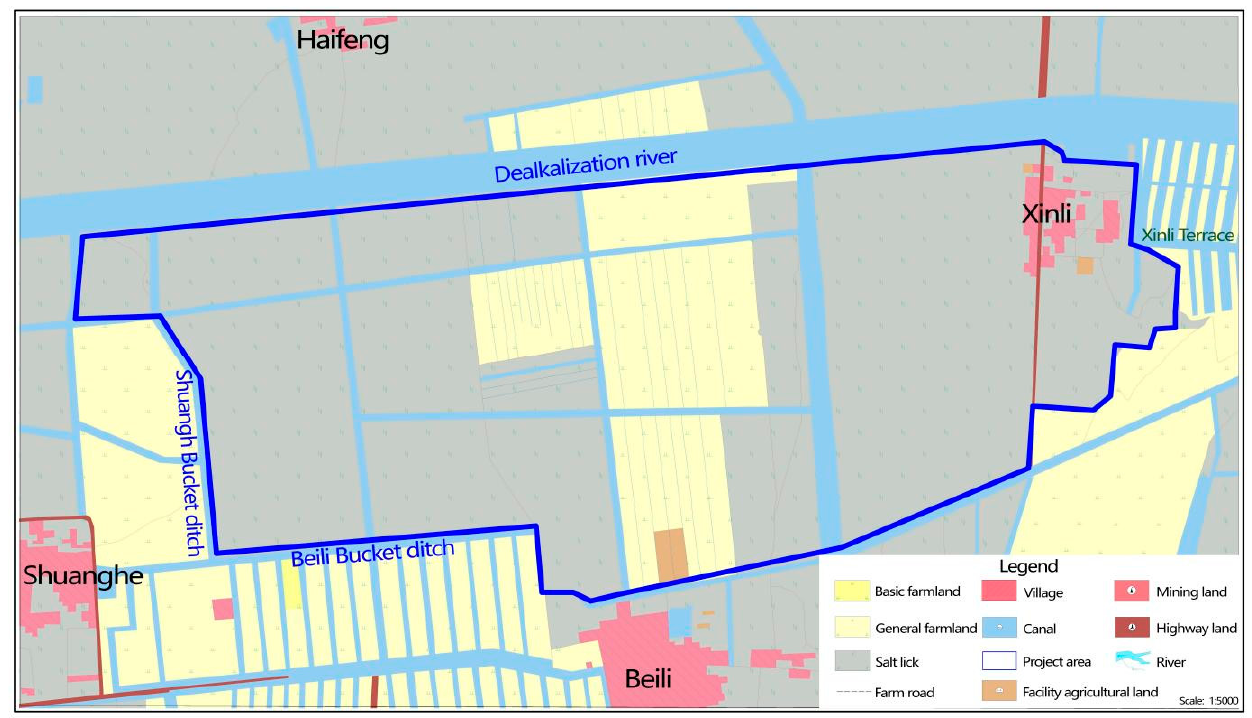
Figure 1. Current land-use map of the project area. Table 2. Design options for different irrigation and drainage modes.